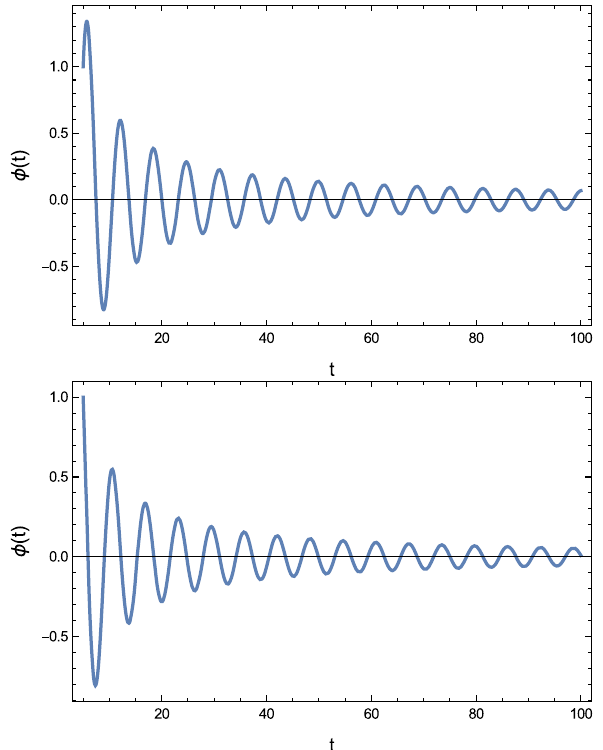
> 0. For the graph dt t = t i